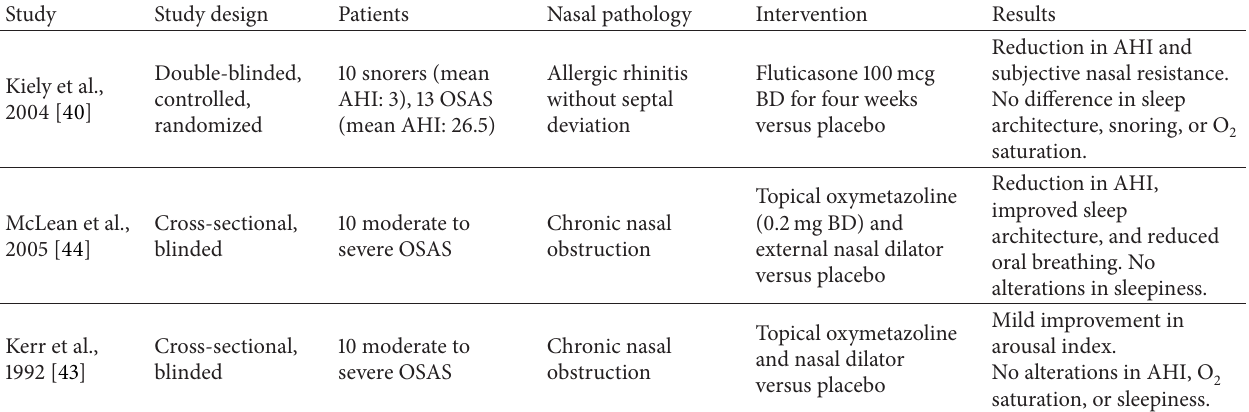
Table 2: Studies on topical medication for the treatment of sleep